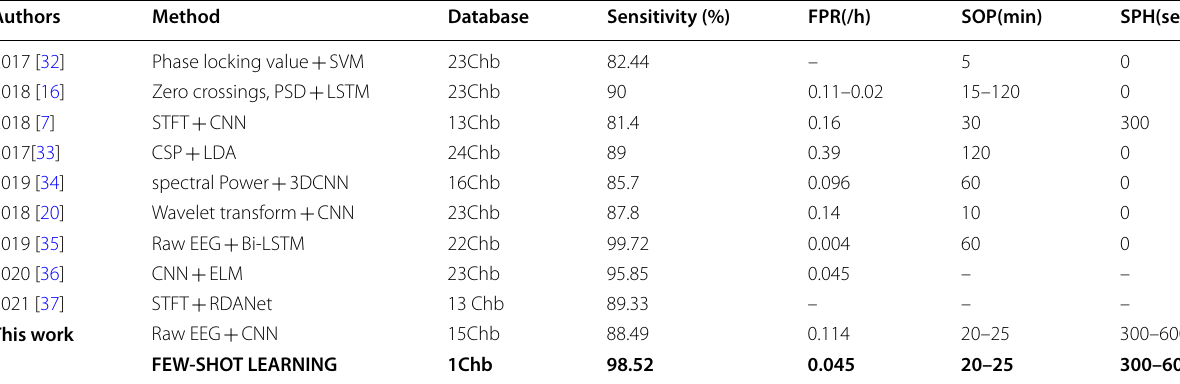
In this work the evaluation results showed a mean sensitivity of 98.52% and FPR period which is improved compared to previous works [7] with an equal forecast